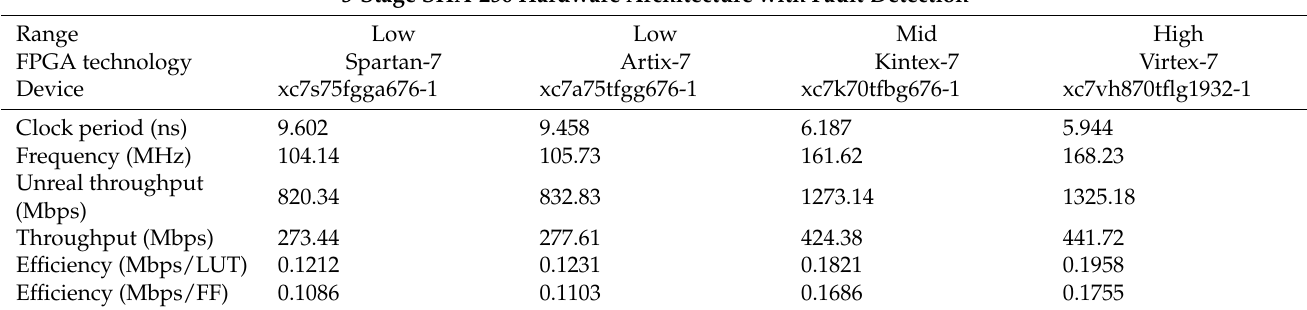
Table 4. Requirements on FPGA for the SHA-256 hybrid-redundancy hardware architecture for detecting faults using a 3-stage pipeline